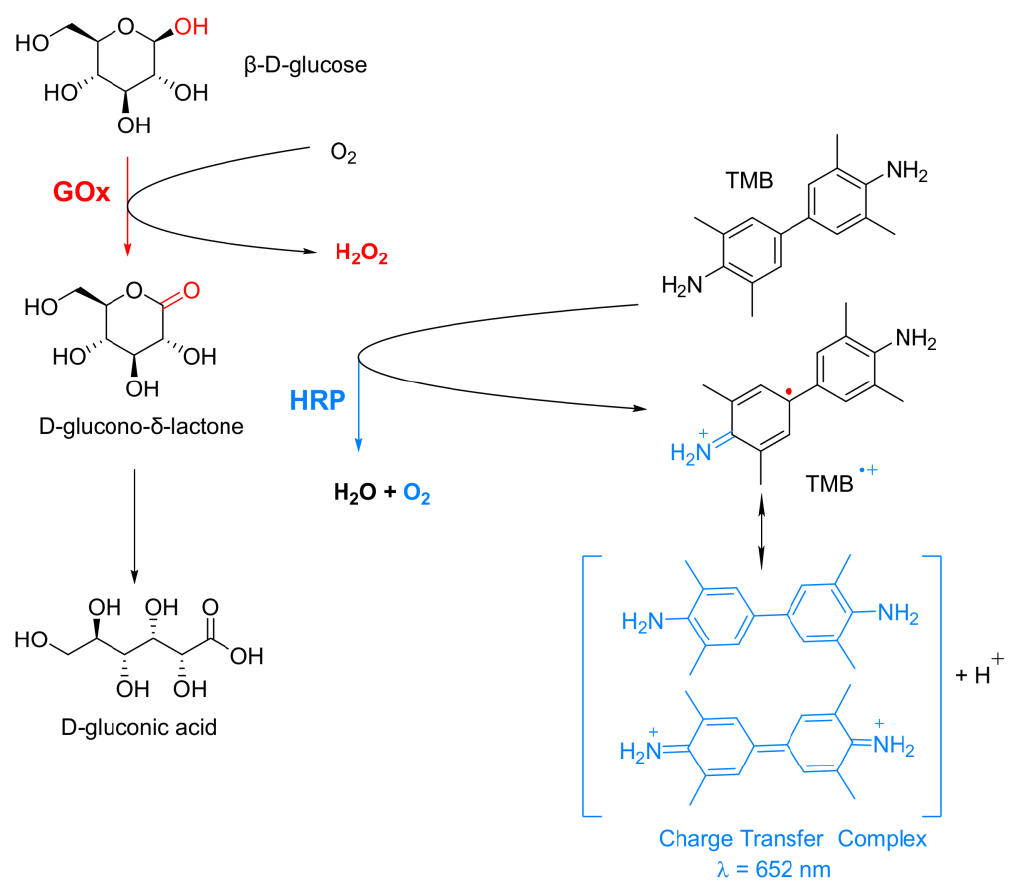
Figure 8. Schematic representation of the bienzyme cascade reaction used for β -D-glucose colorimetric determination. GOx = glucose oxidase; HRP = horseradish peroxidase; TMB = 3,3´,5,5´-tetra- methlbenzidine.